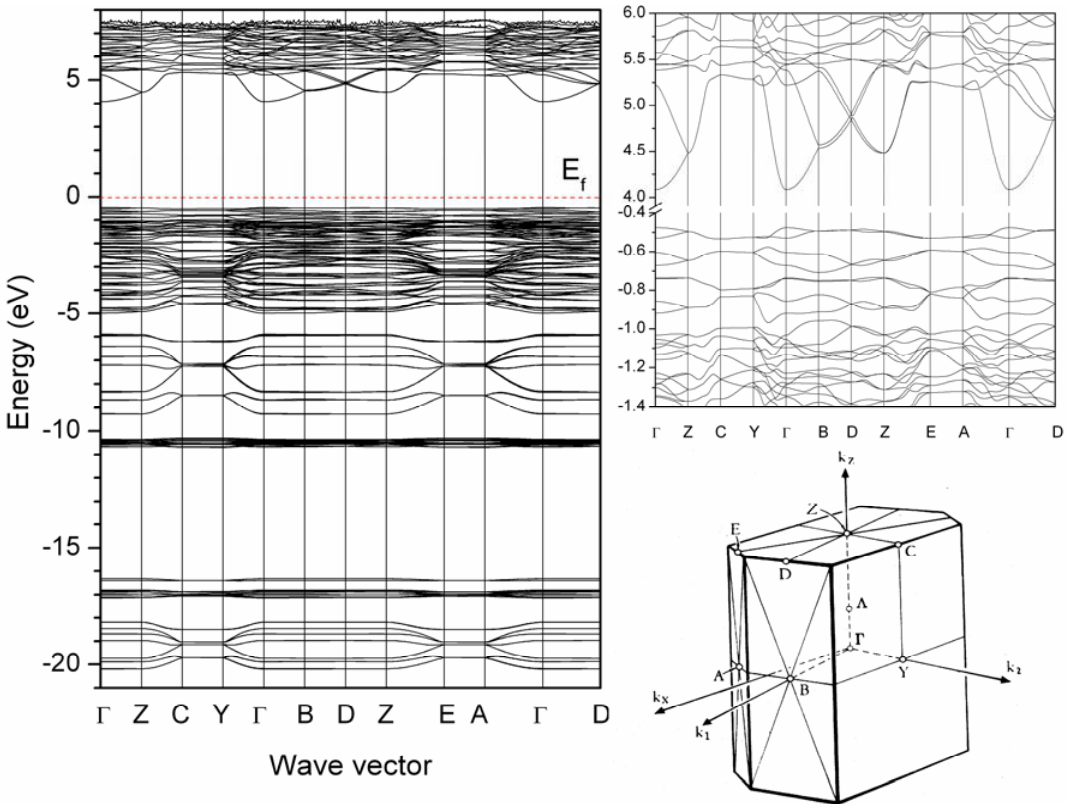
Figure 2. Band structure of Ba of the Ba